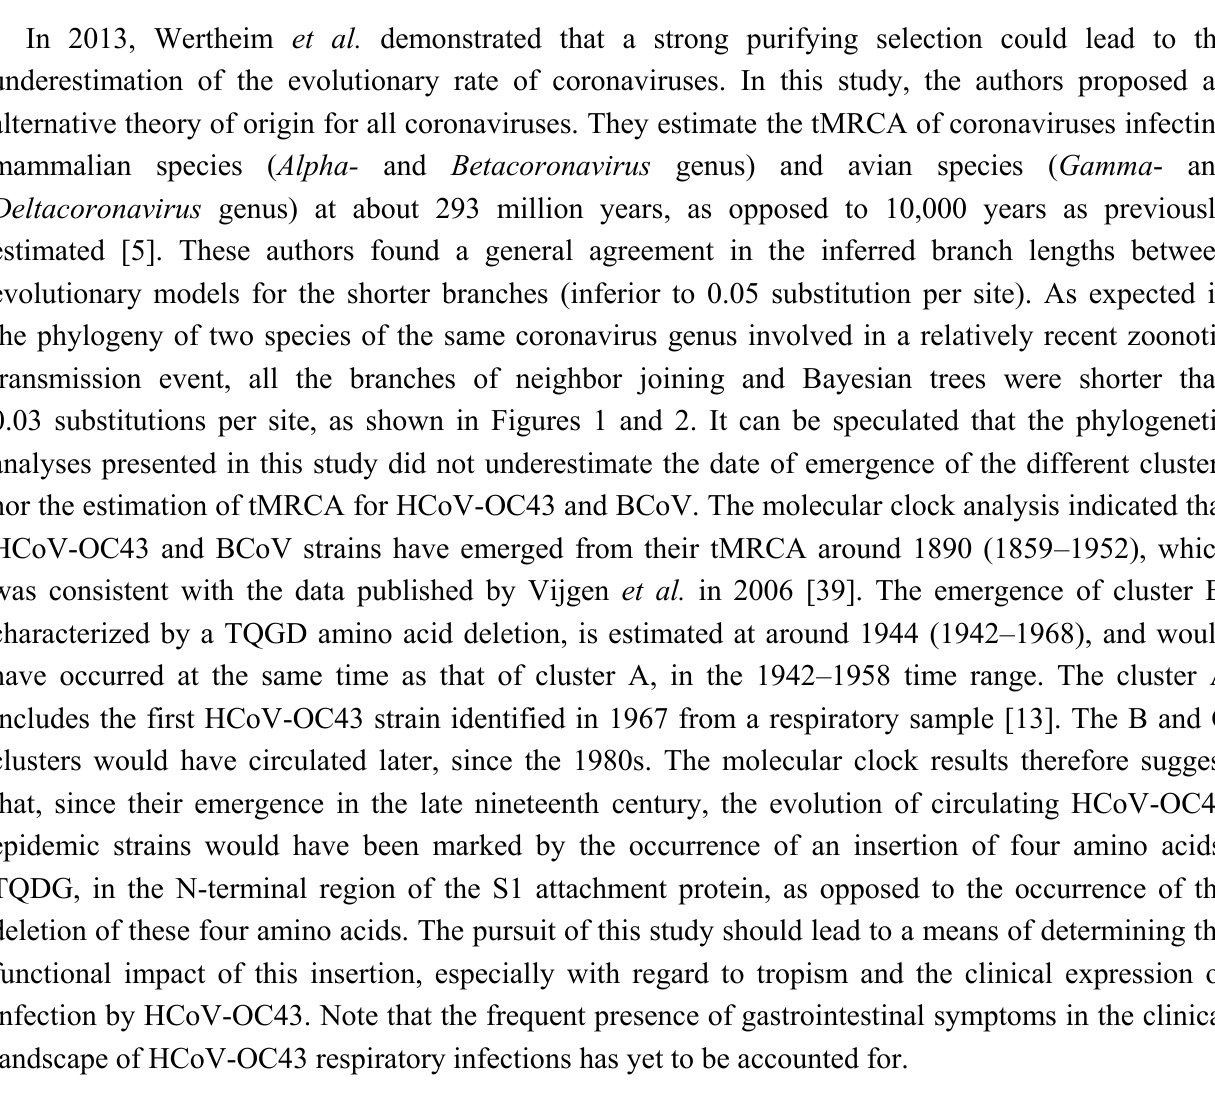
Figure 3. Alignement of some of the S genes sequences. This aligment was made using Bioedit Software version 7.2.5 (Ibis Biosciences, Carlsbad, CA,